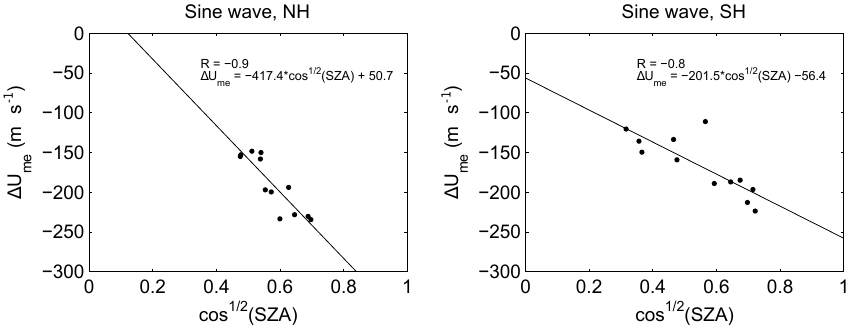
Figure 10. A correlation analysis of the strongest disturbance westward neutral wind at subauroral latitude with cos 1 / 2 (SZA) in both hemi- spheres for the sine-wave oscillation case. The correlation coefficient ( R ) and linear relationship between the parameters are shown in each